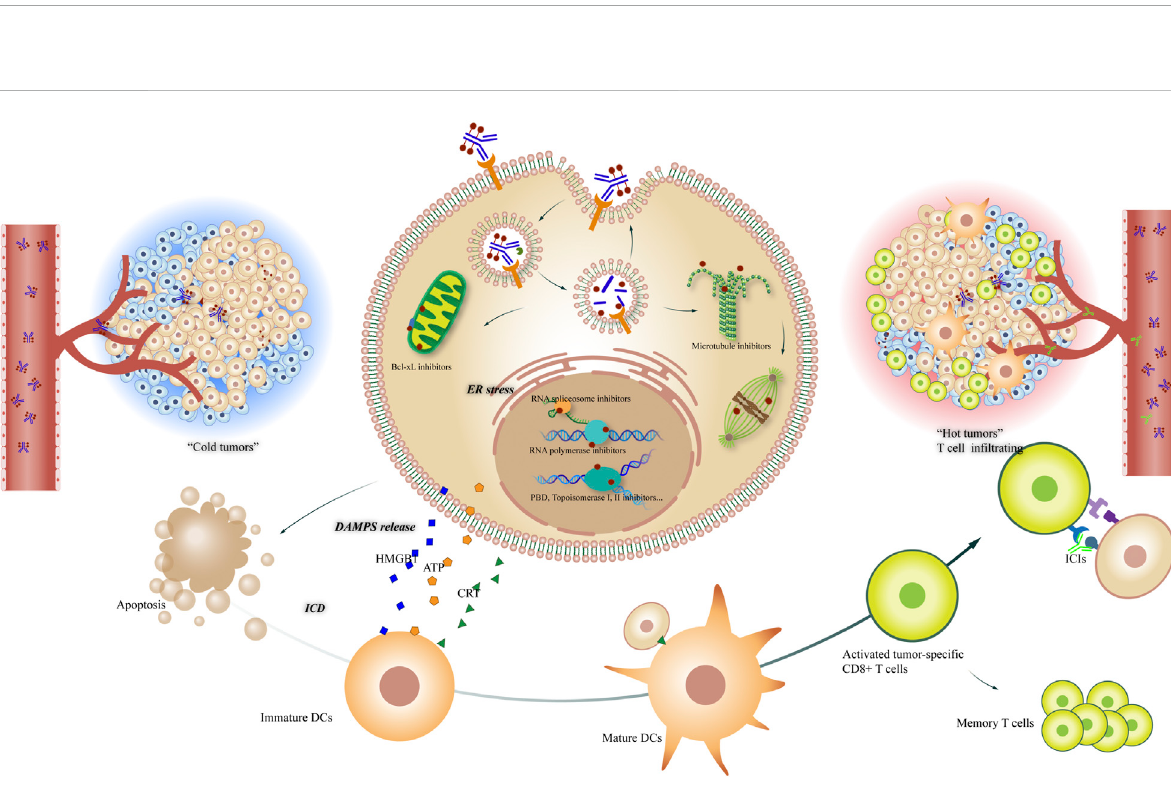
FIGURE 3 Potential mechanisms of ADCs in combination with tumor immunology therapy. Left: “ cold tumor ” without T cell in fi ltrating; right: “ hot tumor ” with active tumor-speci fi c CD8 + T cells, offering a tumor microenvironment to ICIs; center: The different mechanisms of ADCs killing tumor cells, including Bcl-xL inhibiting, RNA spliceosome inhibiting, RNA polymerase inhibiting, DNA damaging and microtubule inhibiting, etc; down: The process that ICDs induce DCs maturing and T cell activating, leading to the convert of tumor